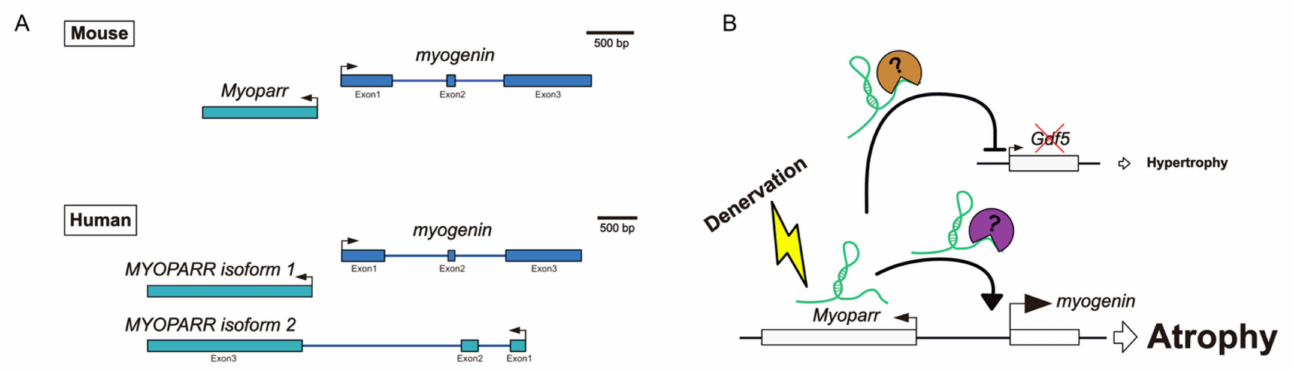
Figure 2. ( A ) Structures of both mouse Myoparr and human MYOPARR . ( B ) Molecular functions of mouse Myoparr in the regulation of muscle mass. Denervation activates Myoparr expression, and then Myoparr increases and decreases myogenin and Gdf5 expression, respectively. Thus, Myoparr promotes muscle atrophy caused by